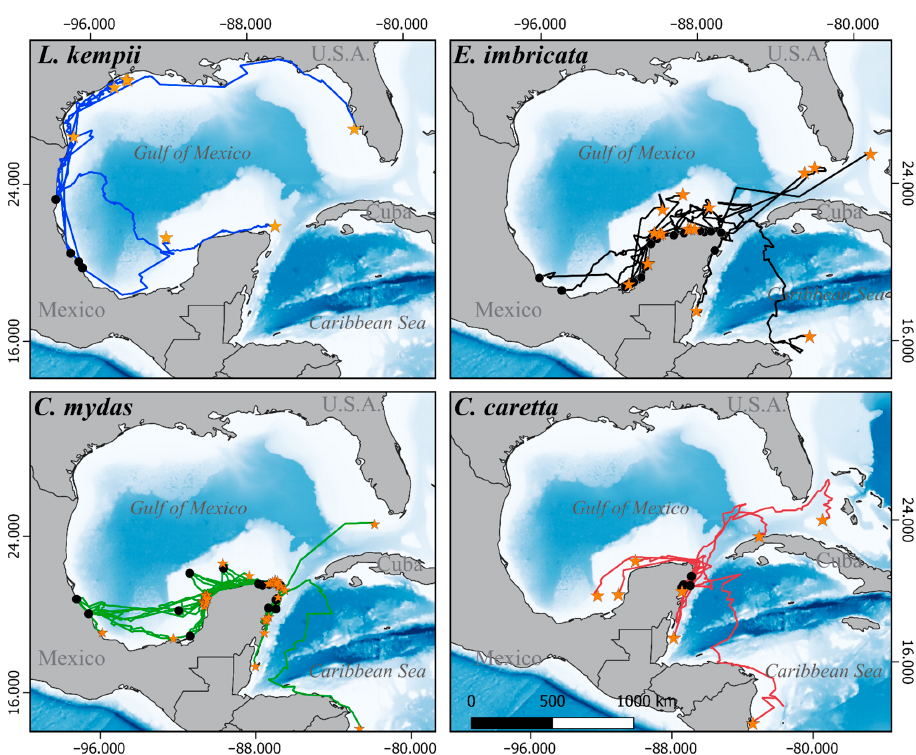
Figure 1. Migratory routes of the Kemp’s ridley ( L. kempii ) , hawksbill ( E. imbricata ) , green ( C. mydas ), and loggerhead ( C. caretta ) individuals that were satellite-tracked from their nesting beaches (black dots) on the Atlantic coast of Mexico, to their final feeding and residency sites (orange stars).